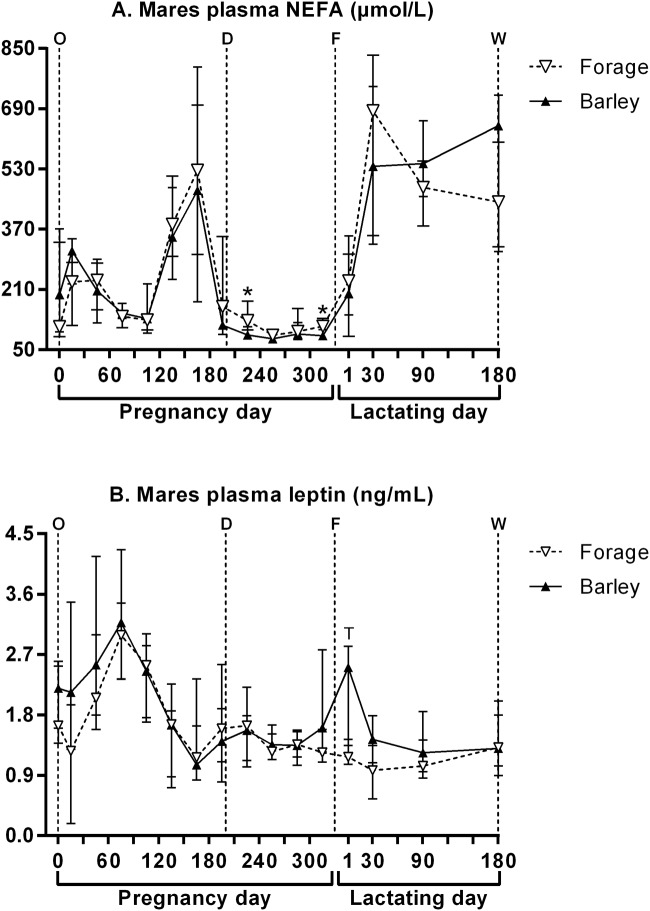
Mares’ plasma NEFA (A) and leptin (B) concentrations (median and IQR) throughout pregnancy and lactation.O: ovulation, D: start of the diet, F: foaling, W: weaning. Values under the asterisks significantly differ and those under letter “T” tend to differ between both groups (Mann-Whitney with FDR adjustment).